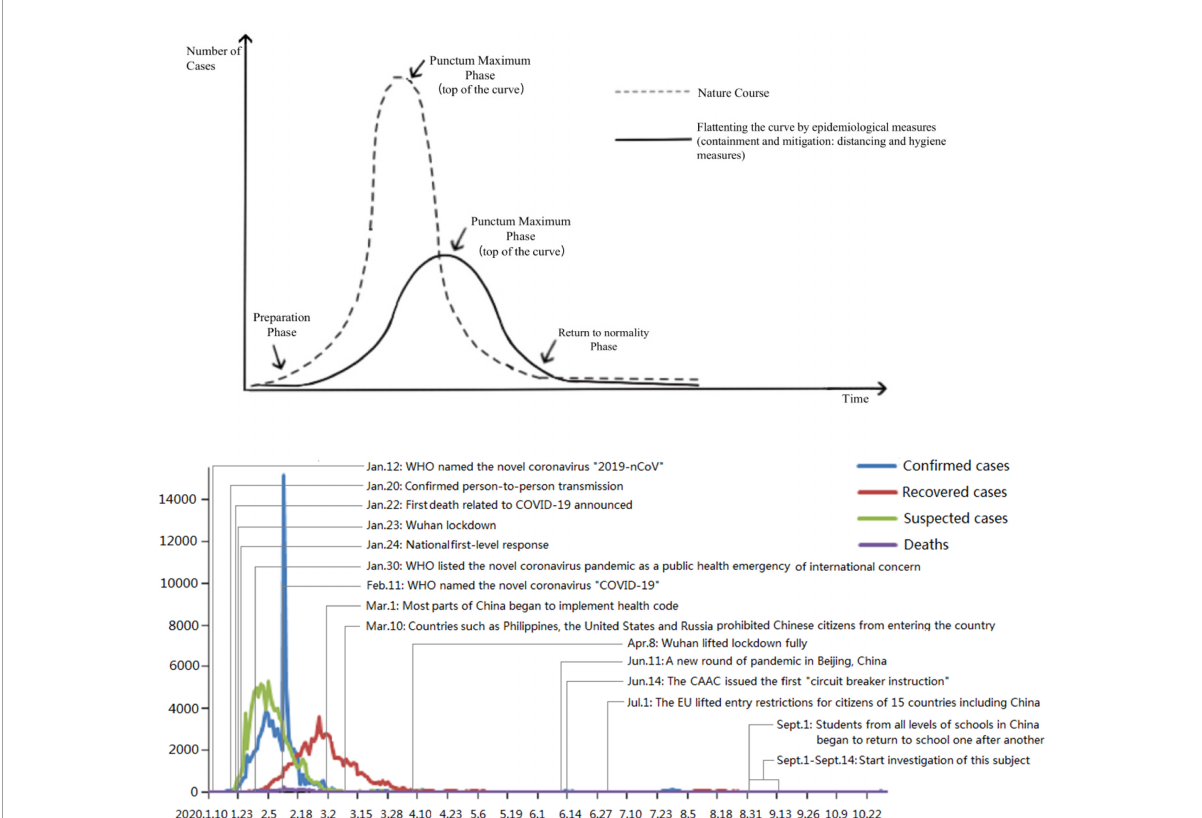
FIGURE1 The development trend and major events of the COVID-19 pandemic in China. Statistics were obtained from the official website of National Health Commission of the People’s Republic of